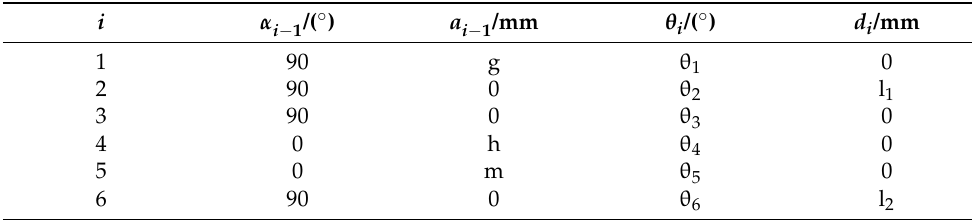
Figure 2. Limb coordinate systems. Table 1. D-H parameters of 6R limb.